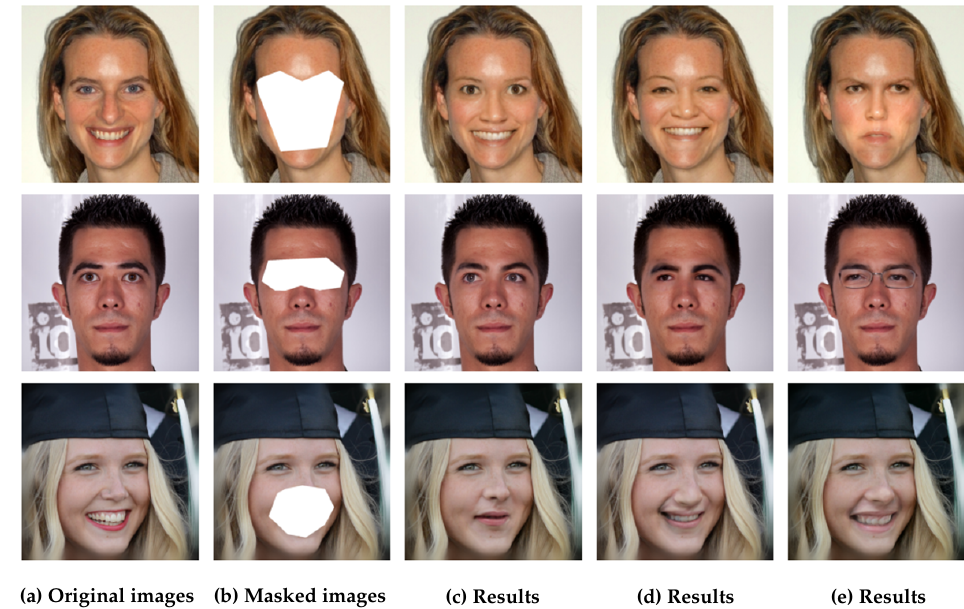
Figure 17. Examples of diversity inpainting